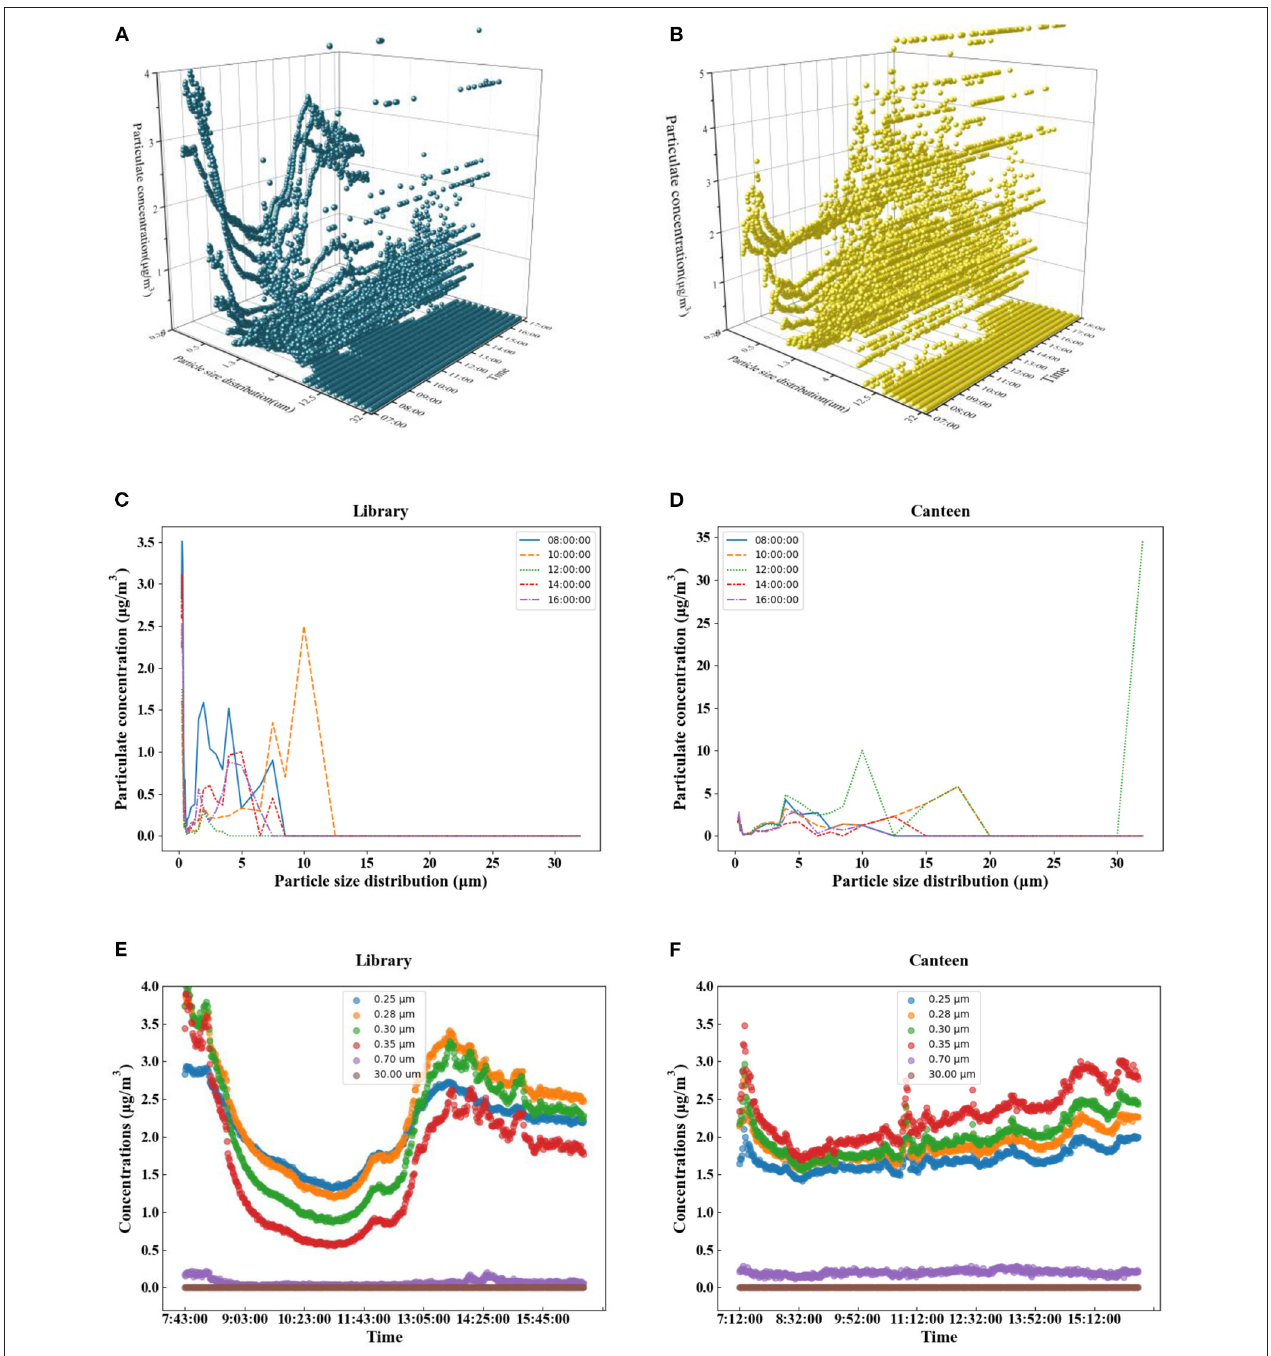
FIGURE 8 | The 95% sample values particle size-time-concentration distribution for the library (A) and canteen (B) . Concentrations of various particle sizes at different times (C–F) .